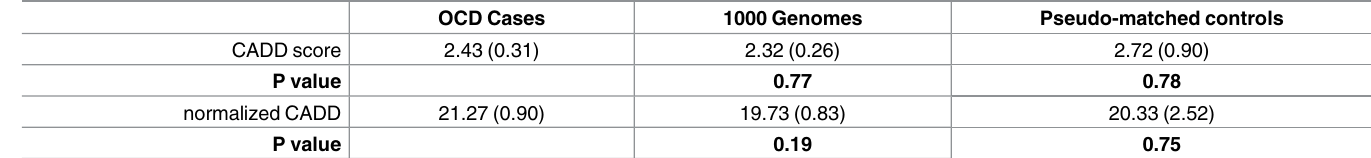
Table 1. In Silico effects of rare non-synonymous Pmutations. Avg (s.e.m.), p values based on Student’sT test.